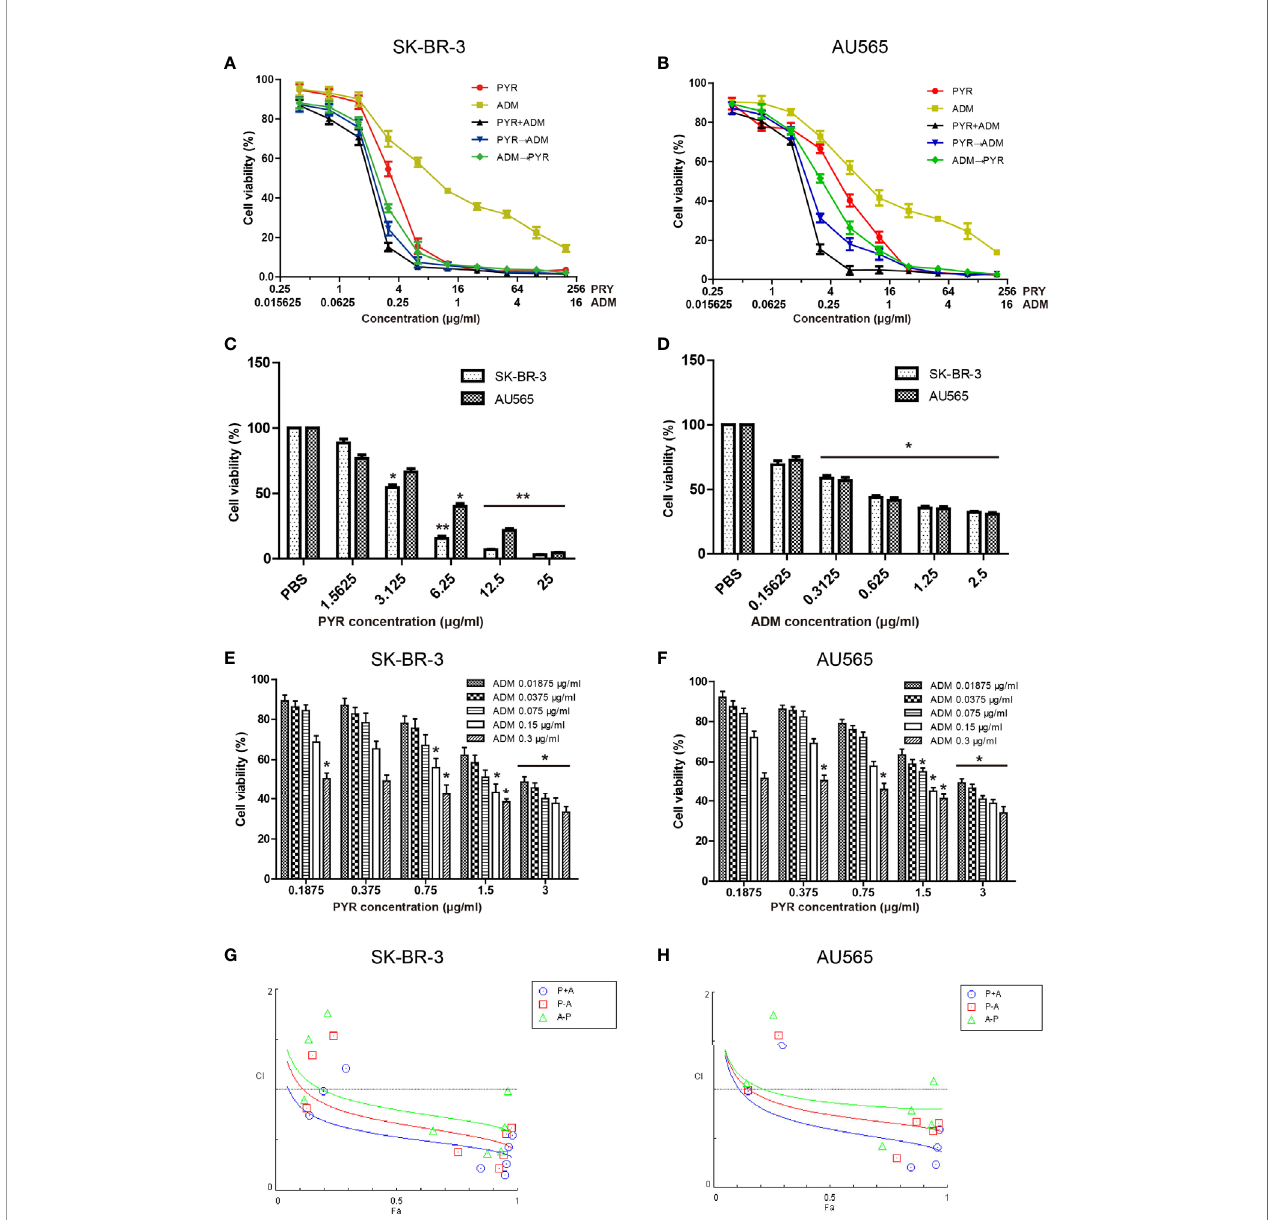
FIGURE 1 | Effects of PYR and ADM on the viability of breast cancer cells. Proliferation activity of SK-BR-3 or AU565 cells was determined by the MTT assay after incubation for 48h with different concentrations of PYR or ADM. (A, B) SK-BR-3 or AU565 cells were treated with PYR or ADM alone or in combination or in sequences (PYR fi rst for 6 h followed by ADM or PYR fi rst for 6 h followed by ADM). (C, D) The histogram represents the statistical analysis for SK-BR-3 or AU565 cells were treated with PYR or ADM alone. (E, F) Proliferation activity of SK-BR-3 or AU565 cells was determined after incubation for 48h with different concentrations of PYR combination with 0.3, 0.15, 0.075, 0.0375, 0.01875 m g/ml of ADM. (G, H) The combination index (CI) v.s. fraction affected (Fa) affected plot was calculated by Compusyn and depicted the combination effects. Synergistic growth inhibitory effects of PYR combined with ADM on SK-BR-3 or AU565 cells. Synergy is de fi ned as CI values < 1.0, antagonism as CI values > 1.0, and additivity as CI values=1.0. *p<0.05 and **p<0.01 compared with the PBS